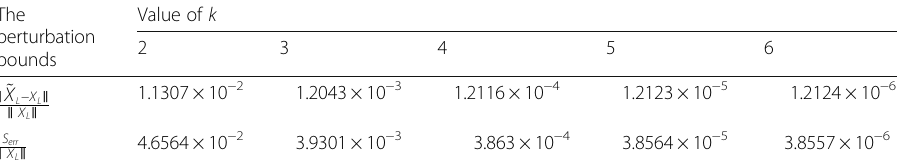
Table 1 Numerical results for the different values of k